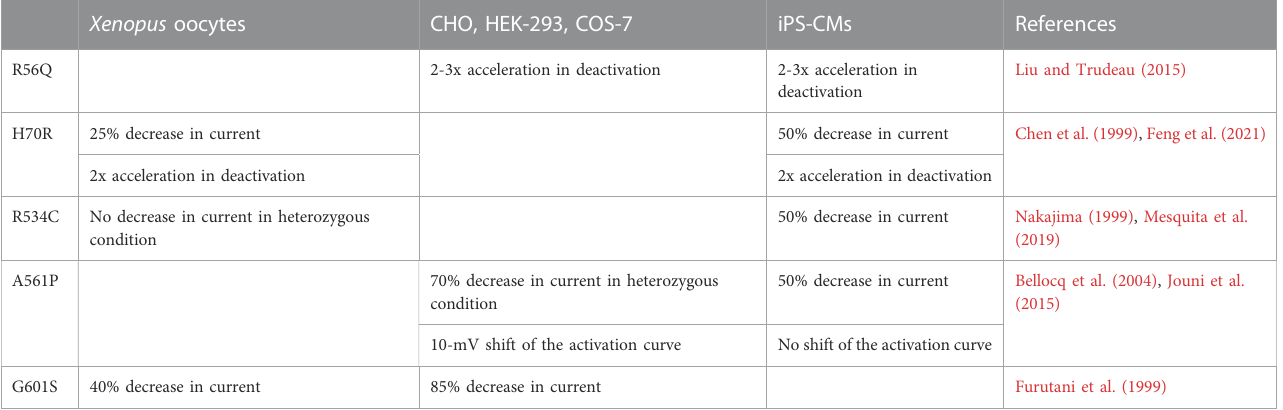
TABLE 1 Major modi fi cations induced by a variant across various